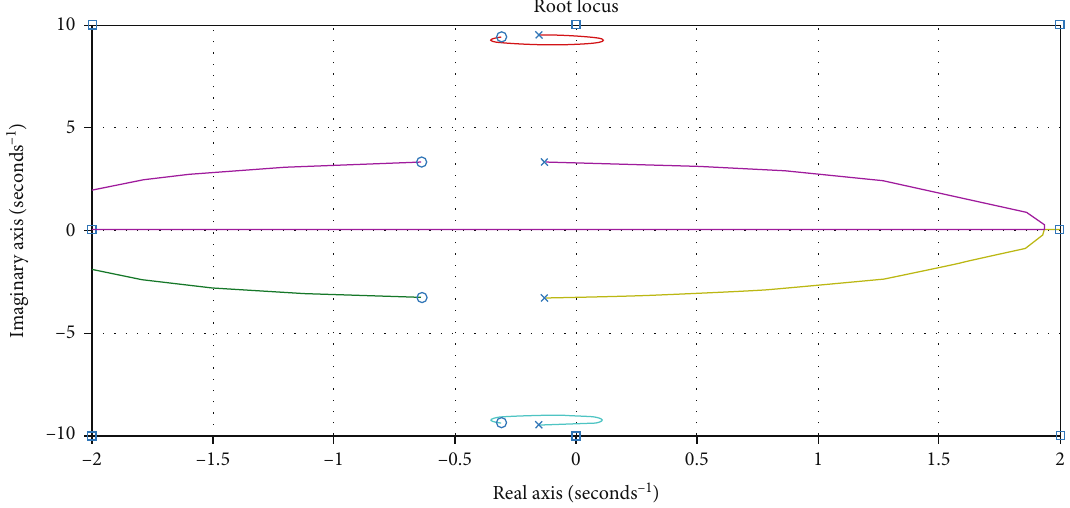
Figure 8: Zoomed view of the dominant poles of the transfer function in the Root Locus.